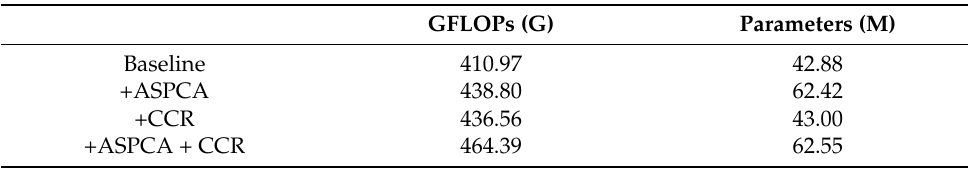
Table 5. Comparisons of computational